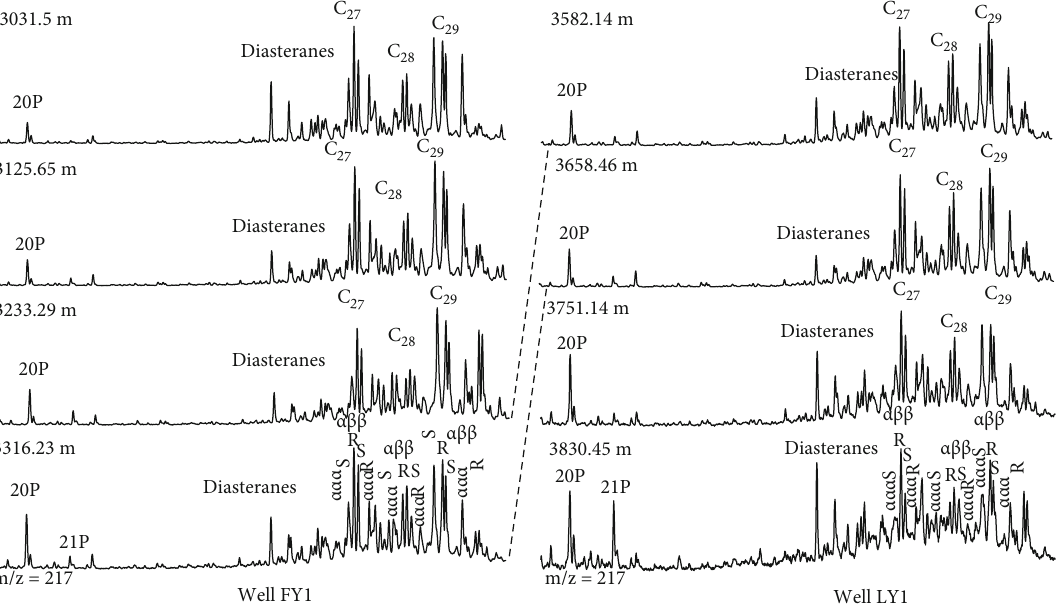
-C pregnanes; ααα S: 5 α (H),14 α (H),21 α (H),20S; αββ R: 20 21